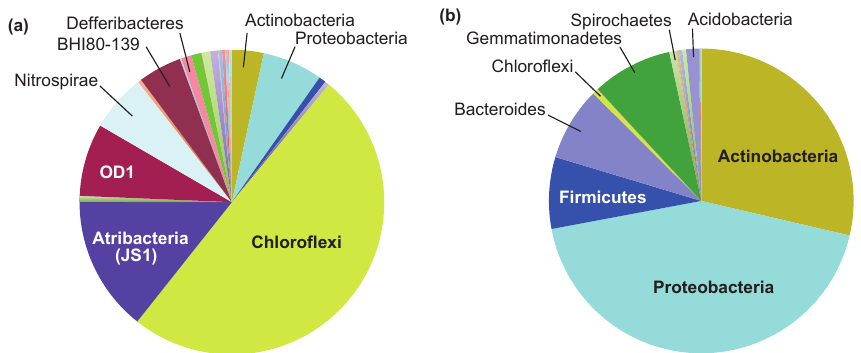
Figure 6. Taxonomic composition of indigenous bacterial communities based on 16S rRNA gene sequences from (a) shallow (five samples from 0 to 365mb.s.f.; a total of 95179 sequence reads) and (b) deep (49 samples from 1.2 to 2.5kmb.s.f.; a total of 5957 sequence reads) sediment samples at Site C0020. This figure is slightly modified from Fig. S3 in Inagaki et al. (2015), and reprinted with permission from AAAS.